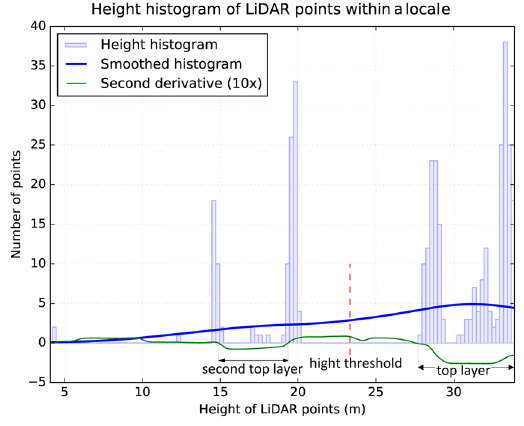
Figure 5. Height histogram of over a hundred LiDAR points within a circular locale used for finding the height threshold for stratifying the top canopy layer in the centre of the